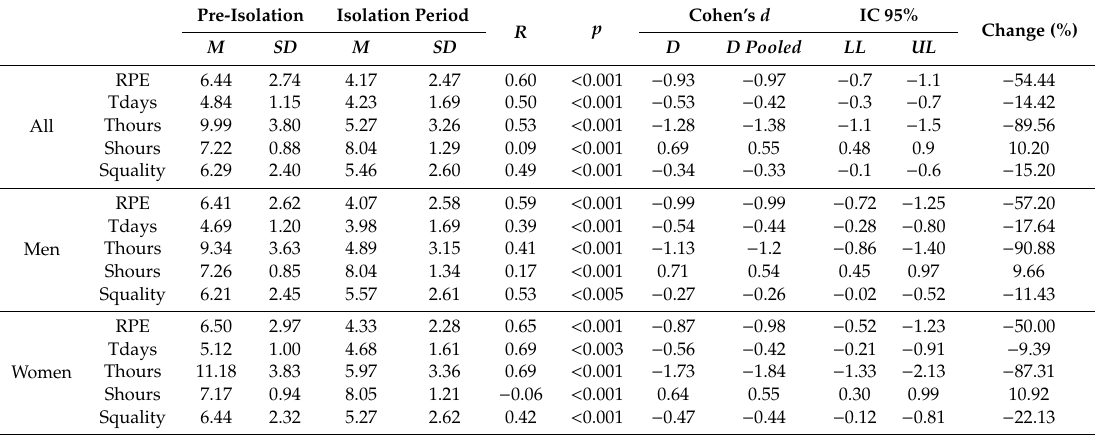
Table 2. Di ff erences on training variables between pre-isolation and isolation period by